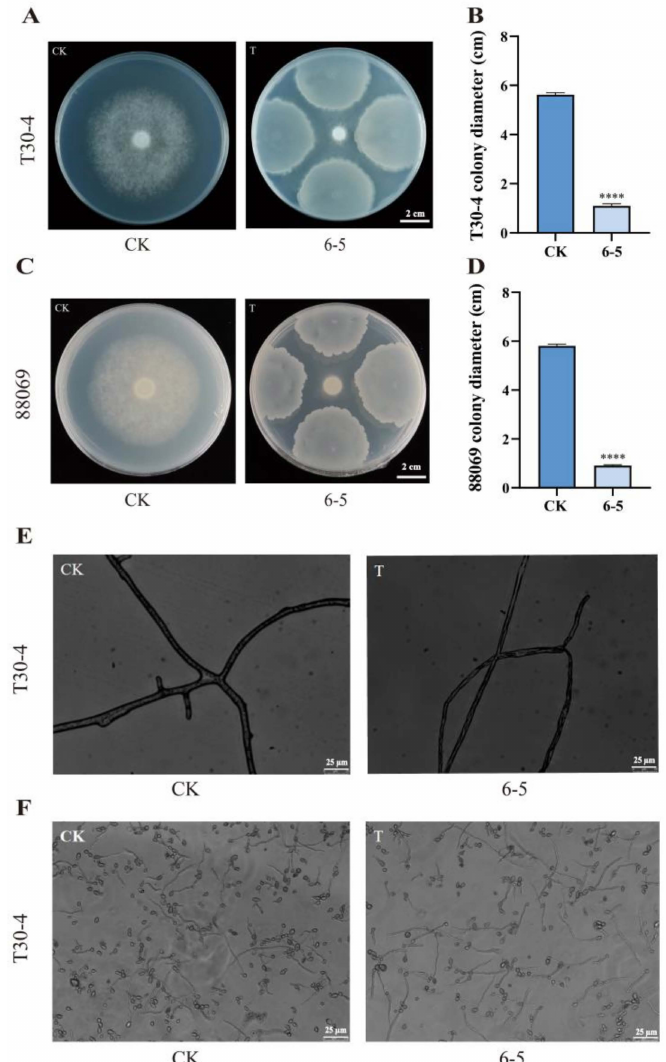
Figure 2. Effect of 6-5 on mycelial growth, hyphal phenotype, and spore germination of Phytophthora infestans . ( A ) Colony morphology of strain T30-4 under 6-5 confrontation; ( B ) colony diameter of strain T30-4 under 6-5 confrontation; ( C ) colony morphology of strain 88069 under 6-5 confrontation; ( D ) colony diameter of strain 88069 under 6-5 confrontation; ( E ) hyphal phenotype of T30-4 treated with 6-5 under the microscope; ( F ) the spore germination of T30-4 observed under a microscope after CK or 6-5 treatment. **** p <